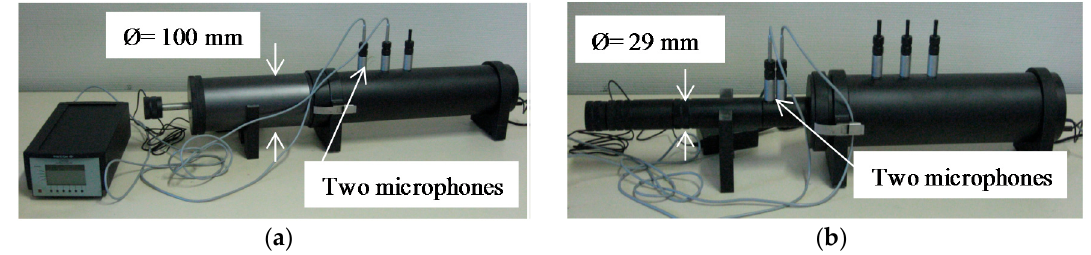
Figure 5. Kundt tube used to measure the sound absorption coefficient for ( a ) low frequencies and ( b ) high